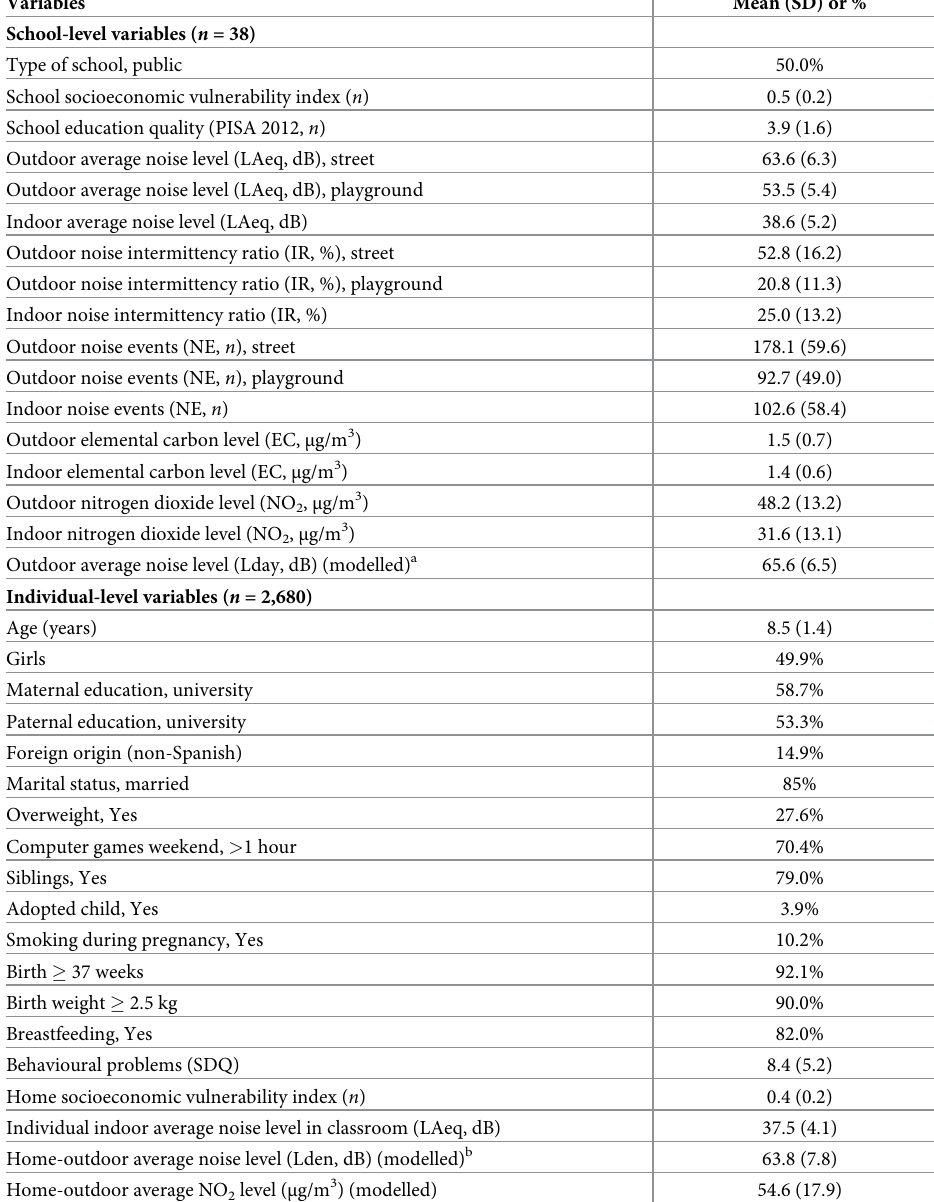
Table 2. School- and individual-level characteristics of the study